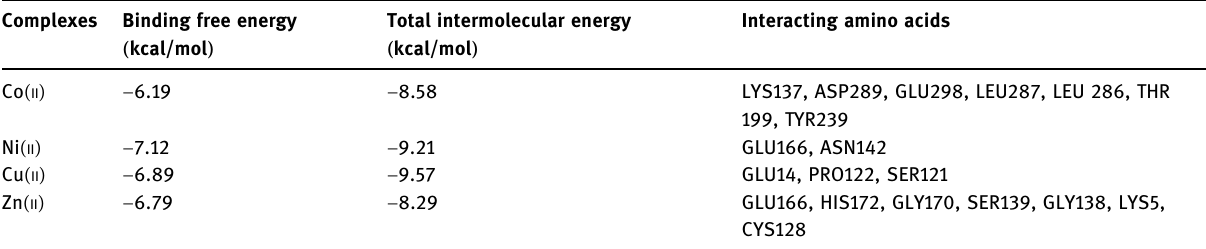
Interacting amino